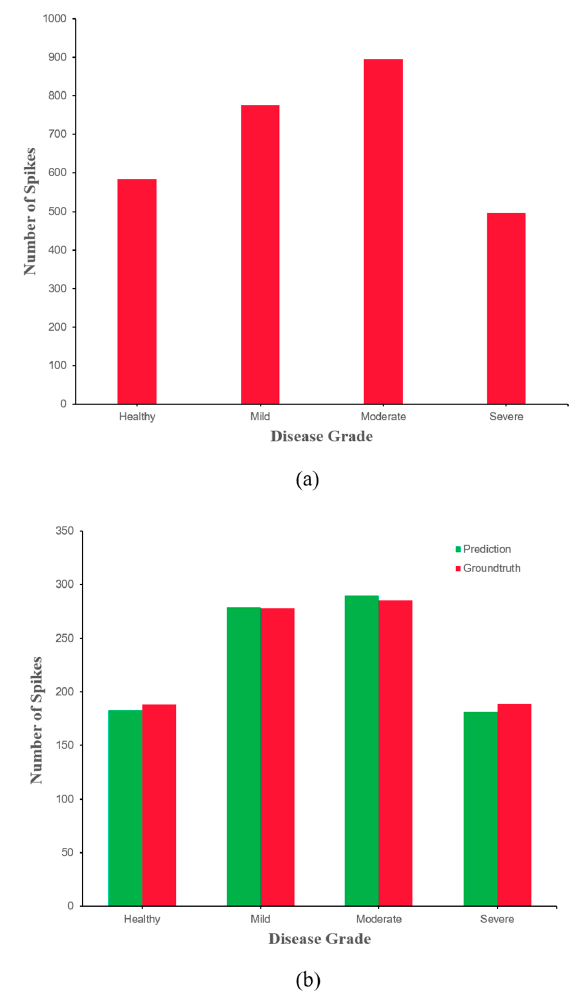
Figure 10. Frequency of wheat spikes for each disease grade: ( a ) the number of wheat spikes for different disease grades in the training set; ( b ) the number of predicted and ground truth spikes for different disease grades in the validation set.